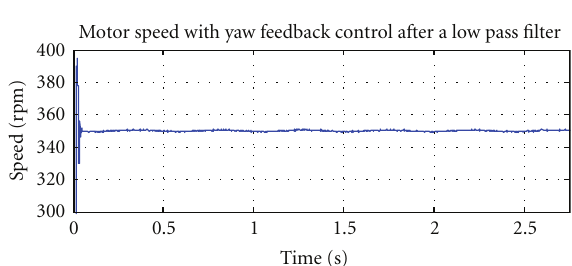
Figure 12: The measured wheel speed with yaw feedback